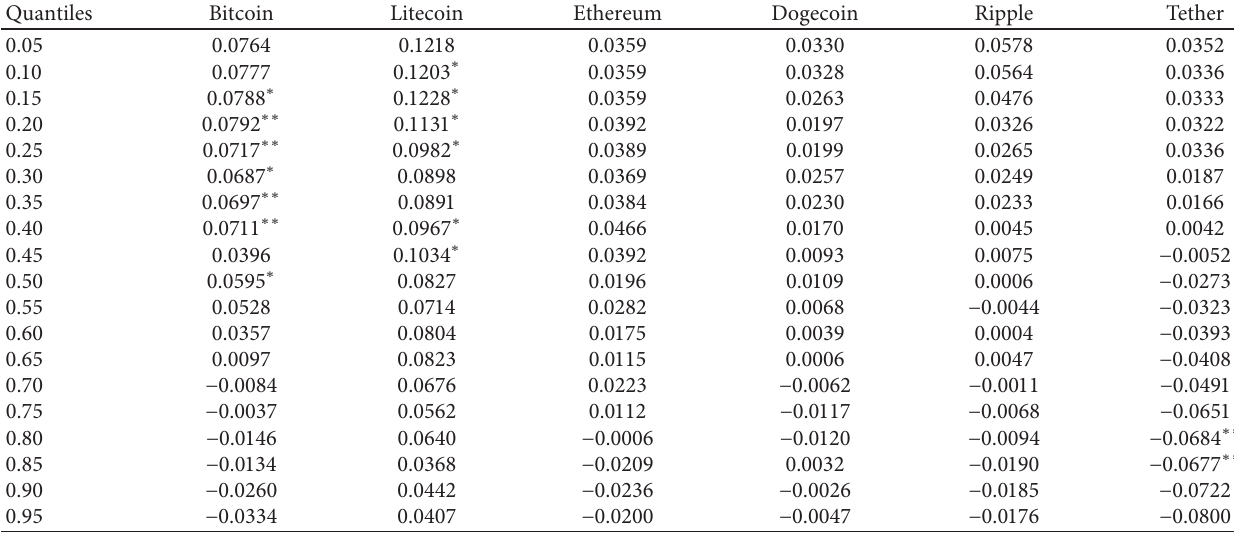
Table 6: Quantile regression results of M3.